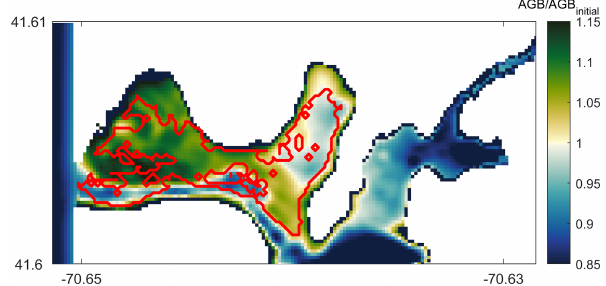
Figure 11. Modeled AGB / AGB initial (aboveground biomass) dis- tribution compared with field data showing seagrass coverage ex- tent (solid red line). Values of AGB / AGB initial > 1 represent sea- grass growth potential and those below 1 indicate potential seagrass decline on day 14 of the